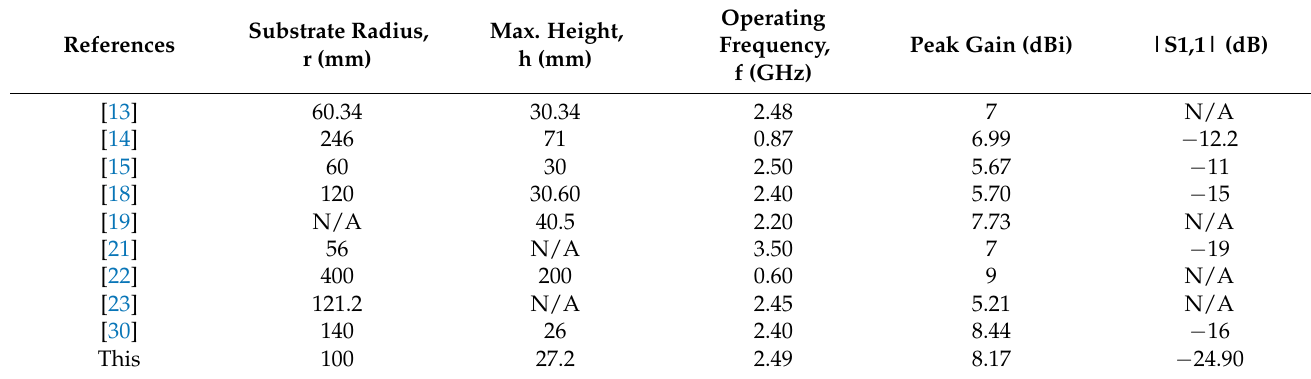
Table 3. Comparative analysis of the single ESPAR antenna.